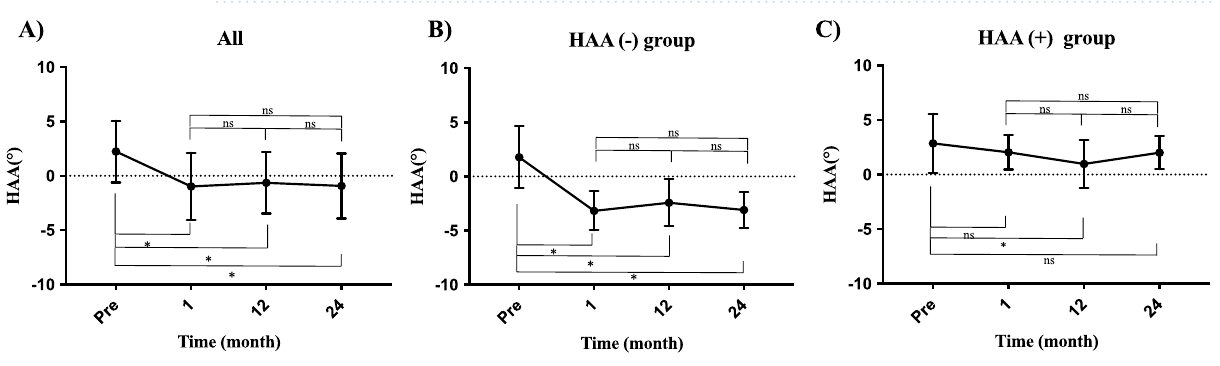
Figure 1. Correlation between HAA and clinical and functional scores and radiological parameters at post- operative 2 year. Correlation between HAA and ( A ) TUG-test, ( B ) HKA, ( C ) WBLR, ( D ) FTA, ( E ) LDFA and ( F ) KJLO.